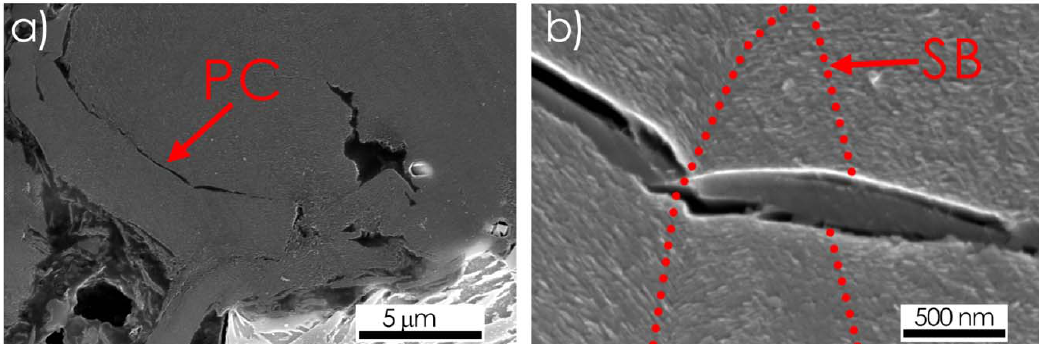
Figure 7. Peripheral cracks (PC) inside graphite spheroid in ADI310 specimen at a distance of 3 mm from the fracture surface, SEM: ( a ) Decohesion path between core and external rim, ( b ) separation of the particular graphene basal plates in neighboring radial sectors, enlarged area of ( a ) (SB: Sector boundary).